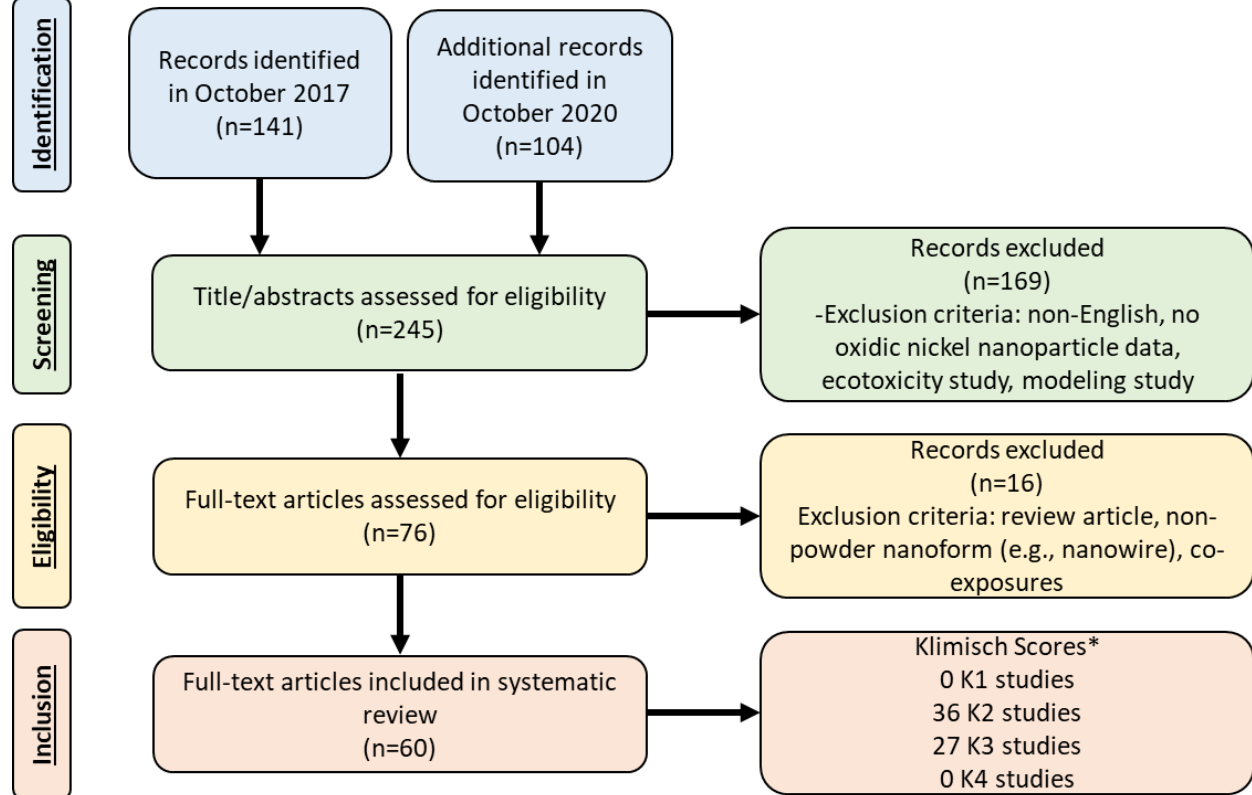
Figure 1. Flow chart of literature review and study selection following inclusion and exclusion criteria. Articles that were identified by the process were included for the full-article review. Replicate entries were removed. * Klimisch scores were evaluated twice for studies with both in vivo and in vitro data.